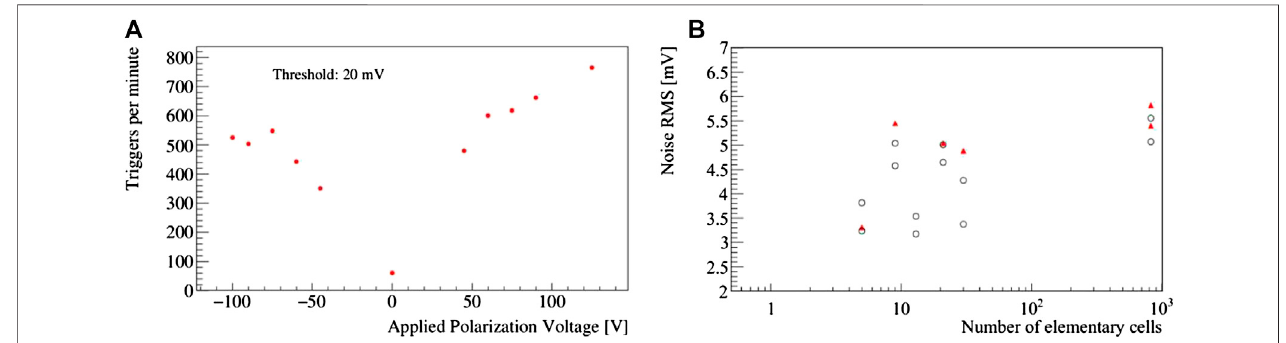
FIGURE14|(A) Thestudy ofthetrigger rateasafunctionofthe polarisation voltage. (B) RMS noiseasafunction ofthenumber ofshort-circuitedelementary cells in several different measurements. In particular, measurements performed during the beam test are represented as red markers, while measurements in the setup with the 90 Sr source represented as black empty